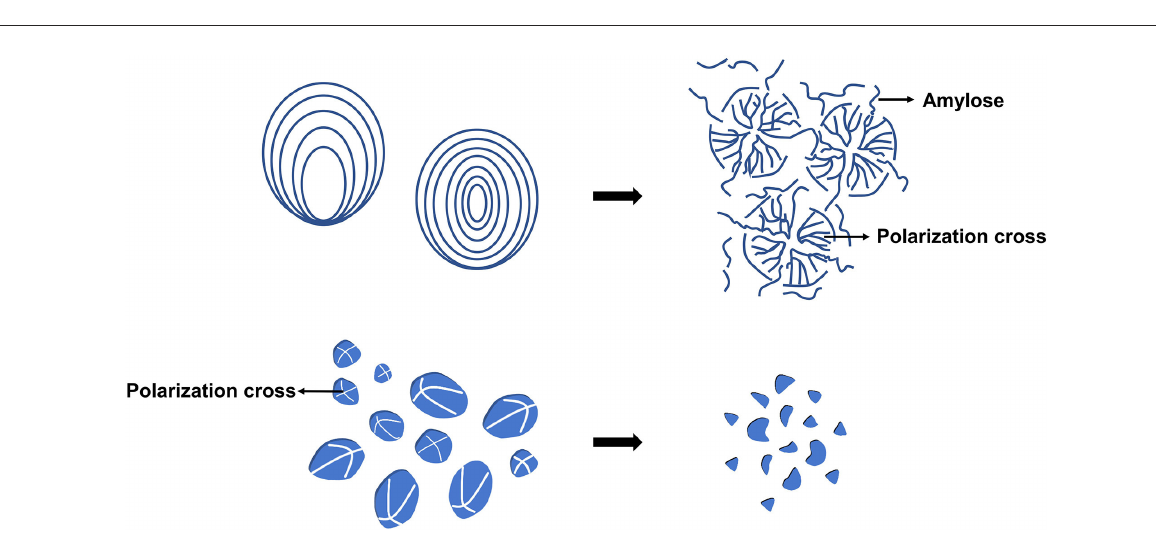
FIGURE5 Morphological changes of starch grains treated by